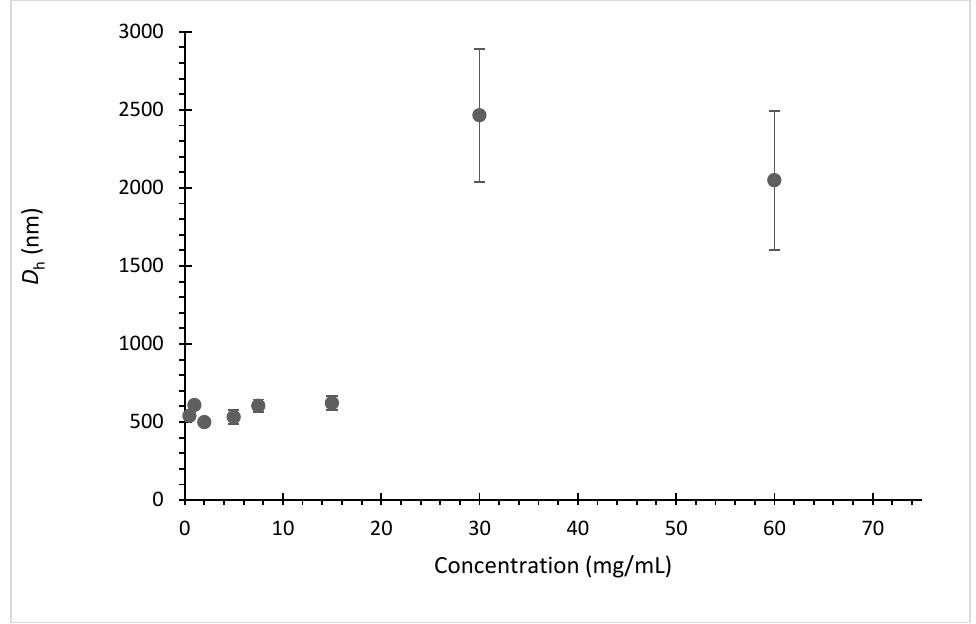
Figure 5. DLS hydrodynamic diameter ( D h ) of TEGMA- ran -FA aggregates in water at temperatures 5 °C above the respective T cp s.